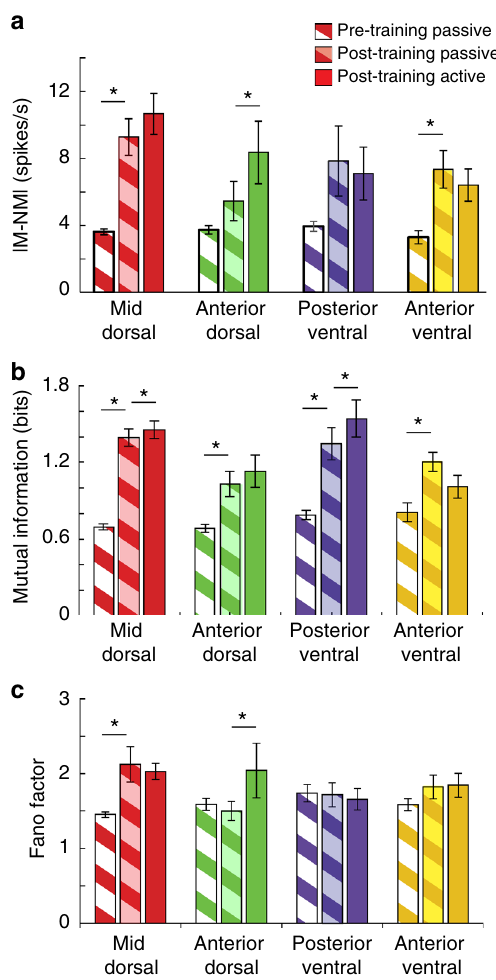
Fig. 8 Task effects. a Comparison of match and nonmatch responses in neurons obtained prior to training, when all stimuli were presented passively, and after training, for neurons tested both with the passive fi xation and with the active working memory task. Only neurons that exhibited signi fi cant elevation of fi ring rate for at least one stimulus condition, at one trial- epoch were included in this analysis (mid-dorsal: n = 368 pre-training, n = 94 post-training; anterior-dorsal: n = 153 pre- training, n = 24 post-training; posterior-ventral, n = 178 pre-training, n = 22 post-training; anterior-ventral: n = 46 pre-training, n = 47 post-training). Stars indicate signi fi cant differences in 1-tailed t -test between pre-training passive and post-training passive measures, or in 1-tailed, paired t -test in post-training passive vs. active comparisons. b Mean Mutual Information values in each prefrontal region. c Mean Fano factor values in